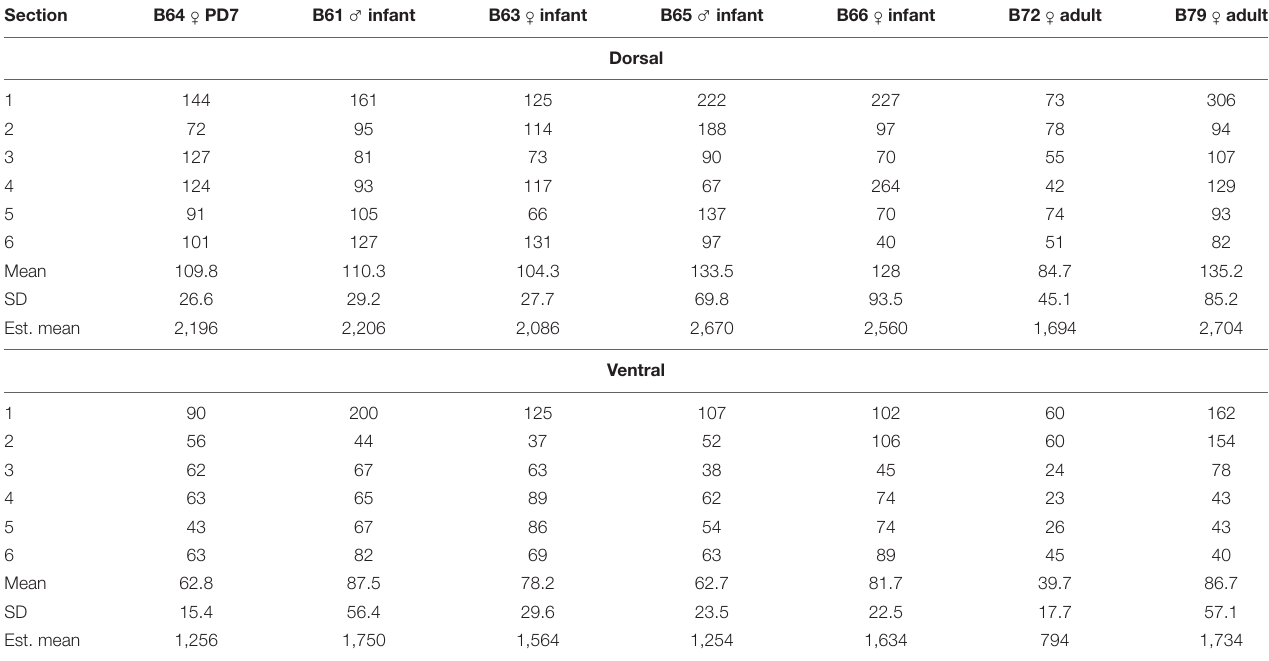
TABLE 3 | Number of plotted NeuN positive cells in the dorsal and ventral ST, at a sampling rate of 1/20 sections (=1.0 mm spacing). Section